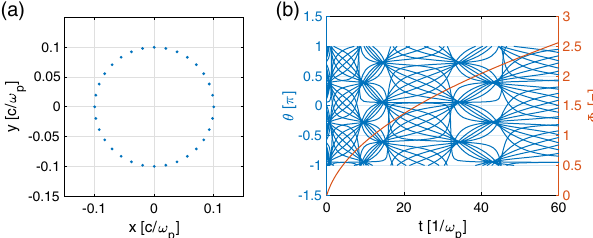
FIG. 9. Left: the initial distribution of the electrons. These electrons are initialized with k ¼ 0 . Right: the evolution of θ and the betatron phase Φ and t i